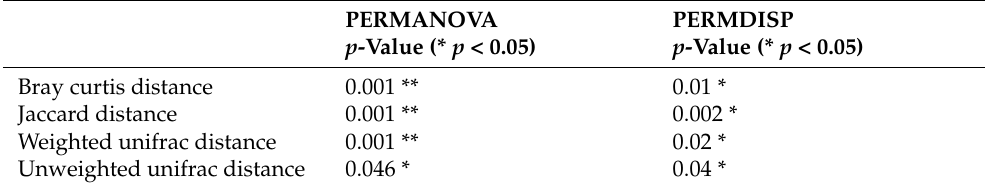
Figure 2. Principal Coordinate Analysis (PCoA) showing the weighted UniFrac distance matrix of bacterial 16S rRNA amplicons from fecal samples of cow (red color) and goat (blue color) groups. Each dot represents one sample. The percentage of variation explained by the plotted principal co- ordinates is indicated on the axes. Table 1. Permutational multivariate analysis of variance (PERMANOVA) and dispersions (PERMDISP) showing significant differences in beta diversity between cows and goats ( p < 0.05).